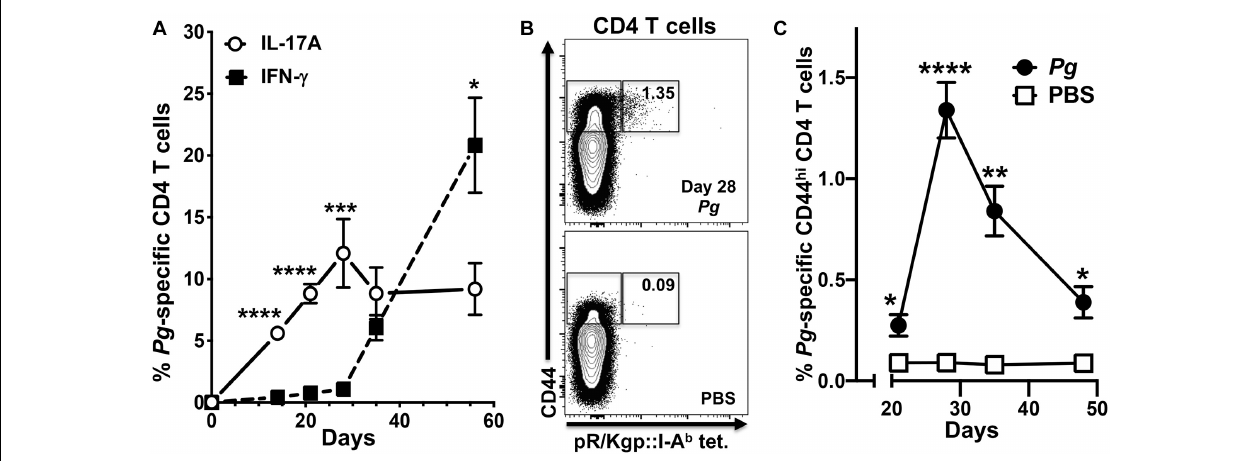
FIGURE 1 | The percentage of P. gingivalis -specific CD4 + T cells expressing IFN- γ increases from day 28 in cervical lymph nodes. Single-cell suspensions from cervical lymph nodes of C57BL/6J mice orally inoculated with Pg or PBS were enriched for CD4 + cells at defined time points and stimulated with PMA/ionomycin in the presence of brefeldin A. Cells were surface stained with anti-mouse CD3, B220, CD8 α , CD4, CD44 fluorochrome-conjugated mAbs and pR/Kgp:I-A b tetramer and then intracellularly with anti-mouse IL-17A and IFN- γ mAbs to identify antigen-experienced gingipain-specific CD4 + T cells by flow cytometry (gated as CD44 bright CD3 + CD4 + pR/Kgp-IA b + B220 − CD8 α − ). Data was pooled from three independent experiments totaling at least 8 mice per group and displayed as mean percentage ± SEM. (A) Summary data of total antigen-experienced pR/Kgp:I-A b tetramer positive CD4 + T cells that expressed either IL-17A or IFN- γ . (B) Representative FACS plots from a Pg and PBS mouse showing pR/Kgp:I-A b tetramer positive CD4 + T cells. Gates are drawn around antigen-experienced CD4 + T cells identified as CD44 bright . The frequency of pR/Kgp:I-A b tetramer positive cells identified as a percentage of the total antigen-experienced CD4 + T cell population is given. (C) Summary data of percentage of antigen-experienced pR/Kgp:I-A b tetramer positive CD4 + T cells. Percentages were compared using two-tailed Student’s t -test. * p < 0.05, ** p < 0.01, *** p < 0.001, **** p <